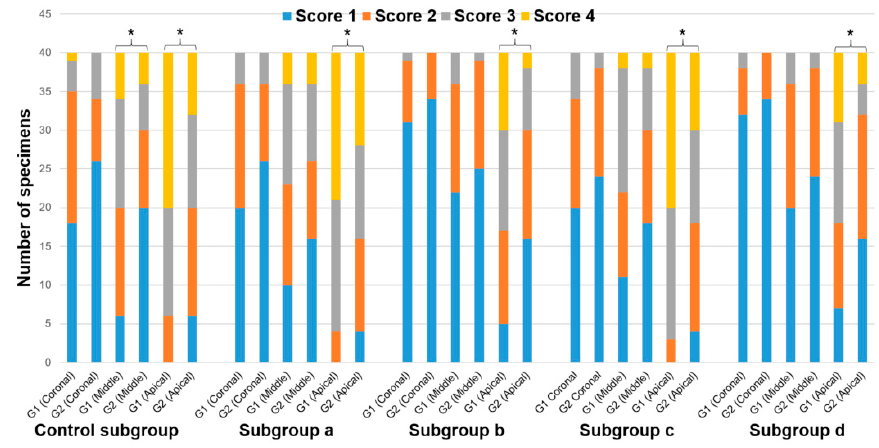
Figure 6. Number of specimens registered for each score of smear layer removal in the different root canal thirds and for each subgroup in groups 1 and 2 (* p < 0.05).